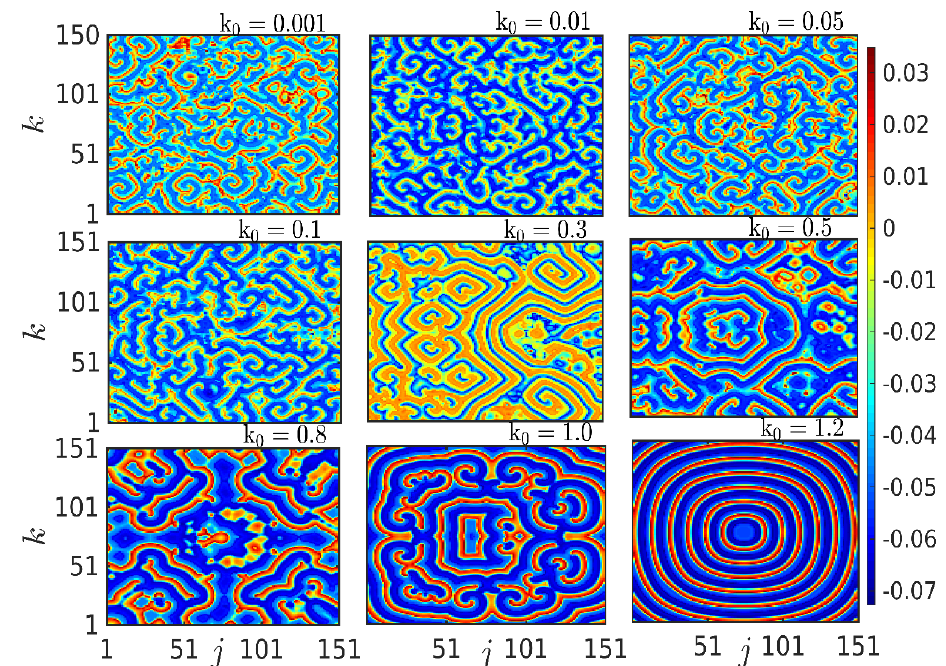
Figure 7. The transition from spiral waves to traveling plane waves in the presence of external stimuli when k 0 was increased to 0.001, 0.01, 0.05, 0.1, 0.3, 0.5, 0.8, 1.0, and 1.2. The other parameter values were fixed as specified in Section 2.